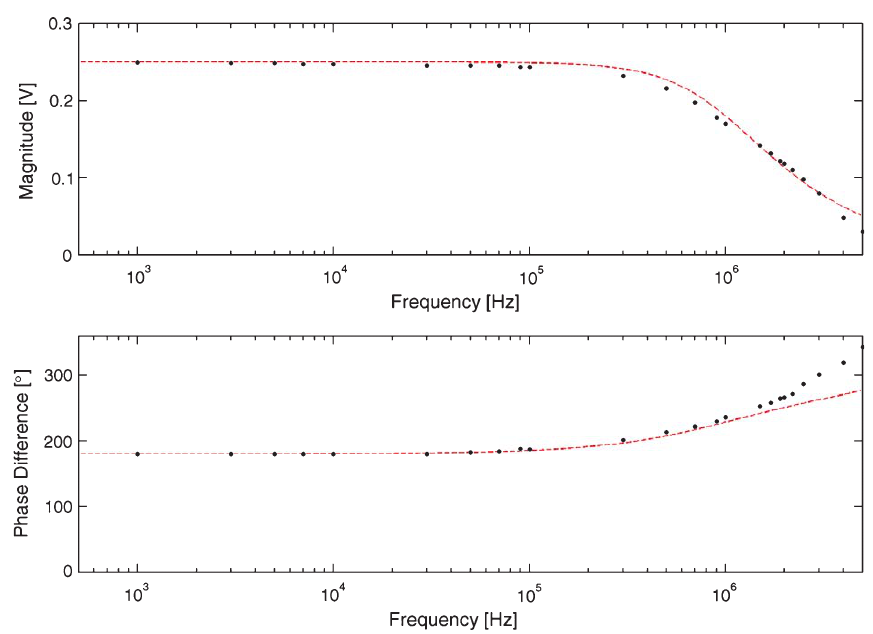
Fig. 14. Electrical impedance reference signal magnitude and phase shift over the range of operating frequencies. The signal is measured at the input to the gain and phase